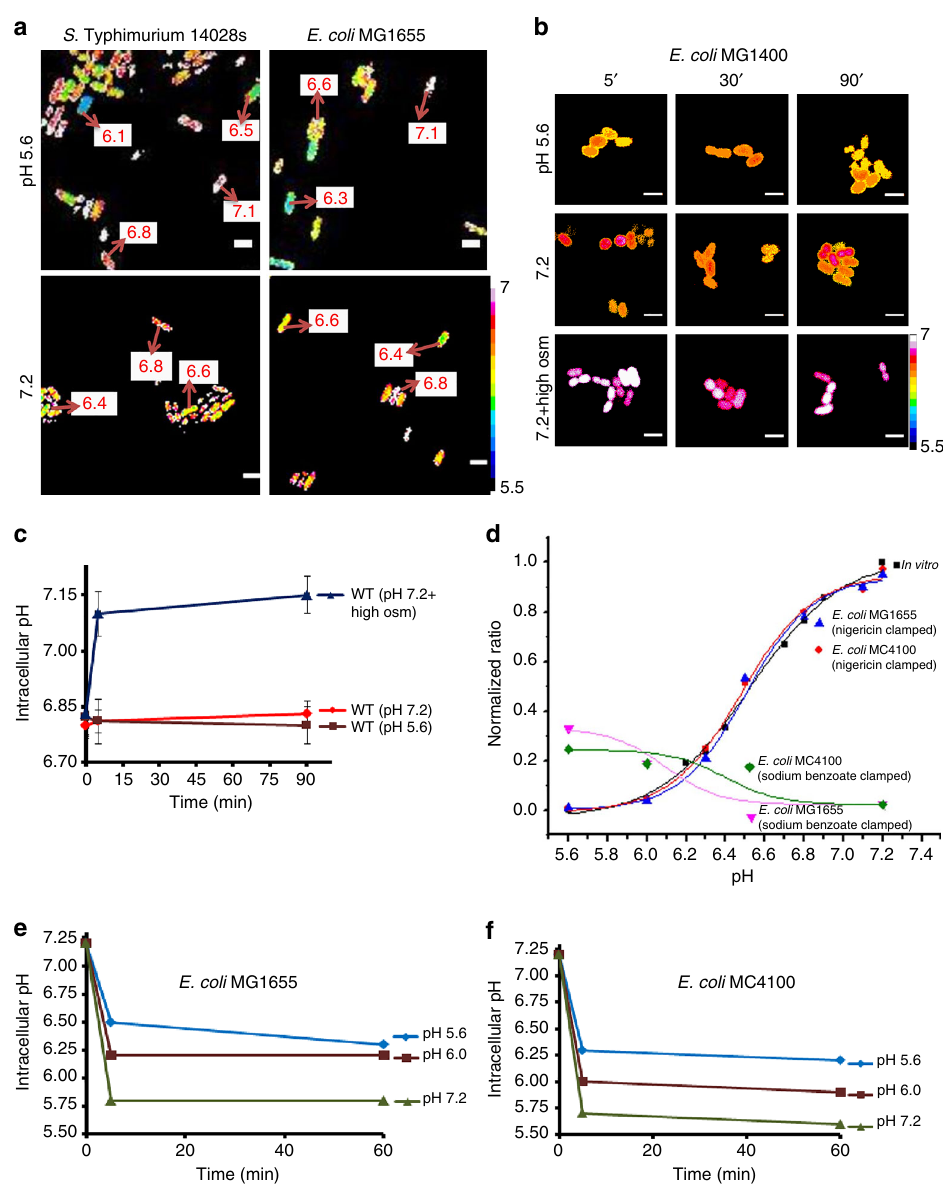
Fig. 6 Spurious results from using pHluorin, MC4100, and clamping agent sodium benzoate. a S. Typhimurium and E. coli strains harboring a plasmid containing pH-sensitive gfp (pHluorin) exhibit heterogeneity in pH i . Representative epi fl uorescence (R 405/488 ) ratio images of emission channel 525 nm upon 405 nm excitation and 488 nm excitation were obtained for wild-type cultures at either acidic pH e 5.6 or neutral pH e 7.2. Using ImageJ software, the ratio images were color coded with blue (ratio = 0.1) to white (ratio = 1). Scale bar, 3 µ m. The pH of individual cells after 30 min is indicated in the panel. b Representative epi fl uorescence ratio images (R 488/440 ) were obtained for wild-type cultures of E. coli MC4100 incubated at pH e 5.6, pH e 7.2, and pH e 7.2 with 15% (w/v) sucrose at the indicated times. Scale bar, 3 µ m. c A plot of the intracellular pH of 50 cells incubated under acid and osmotic stress conditions at each indicated time. Error bars represent mean ± s.e.m. ( n = 3). d Cells were clamped by either 40 μ M nigericin or 30 mM sodium benzoate and the R 488/440 ratio intensities were plotted as a function of pH and overlaid on their in vitro calibration curve. Intracellular pH values determined from BCECF fl luorescence of e E. coli MG1655 and f MC4100 clamped with sodium benzoate at pH e 5.6, pH e 6.1, and pH e 7.2 were